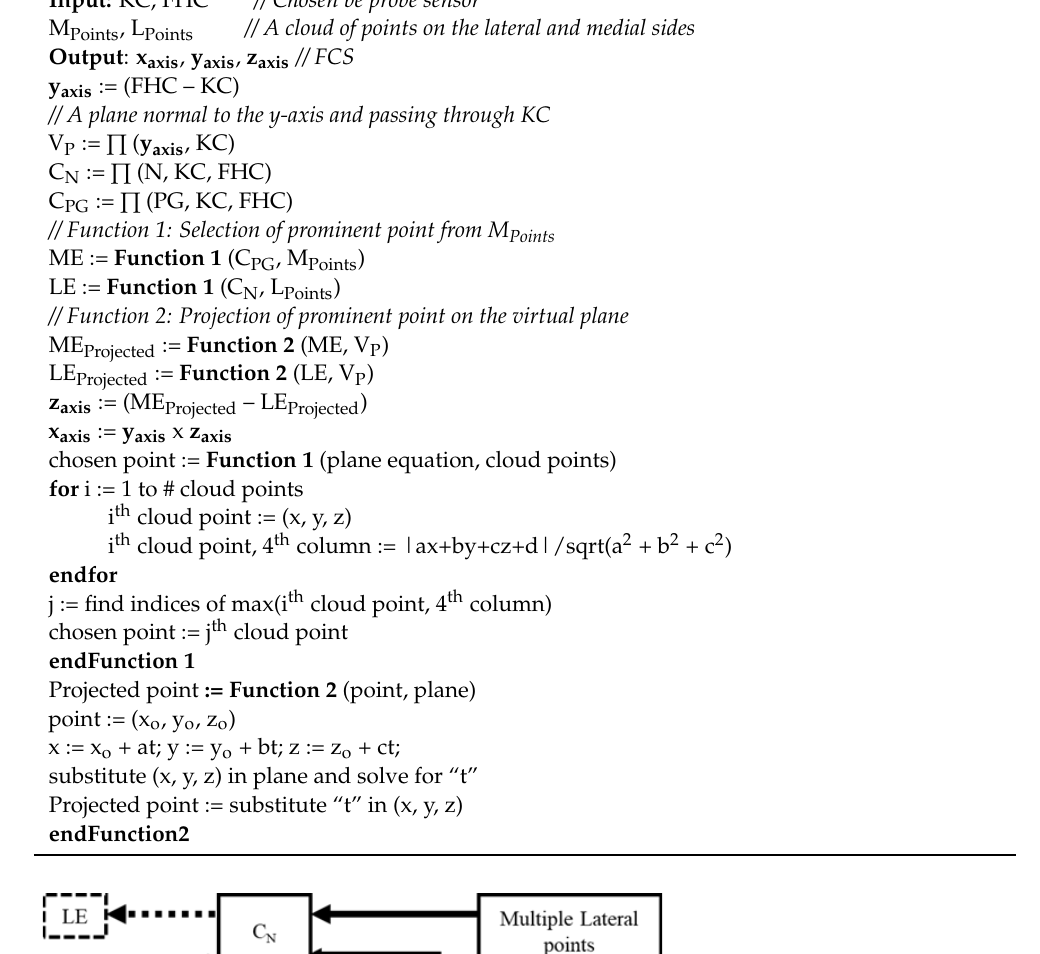
Algorithm 1: Modified Whiteside’s line for FCS